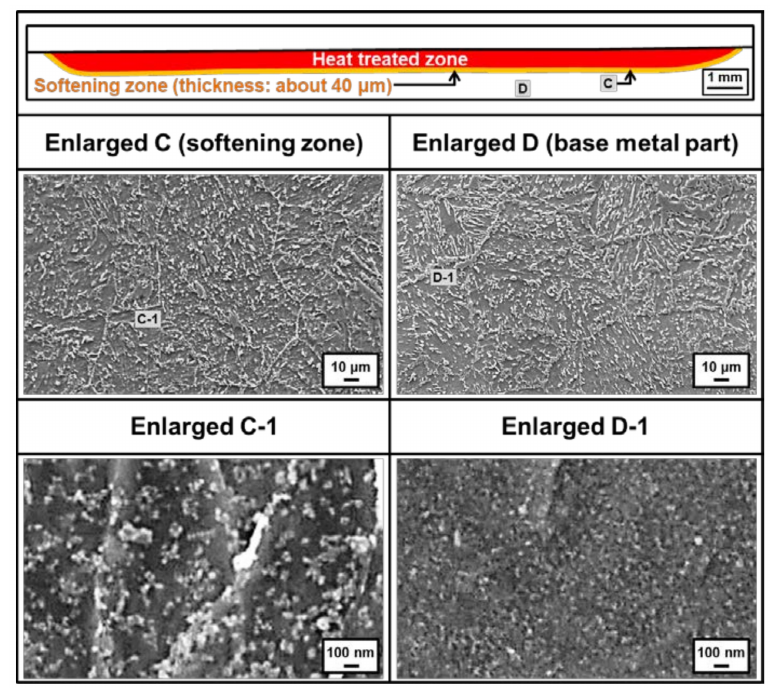
Figure 14. Comparison of SEM micrographs of the softening zone and base metal region of P21 steel after laser-assisted heat treatment at 1473